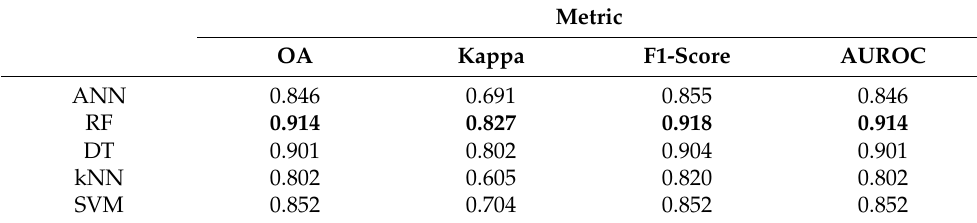
Table 4. Assessment of models with a dataset created based on a ratio of